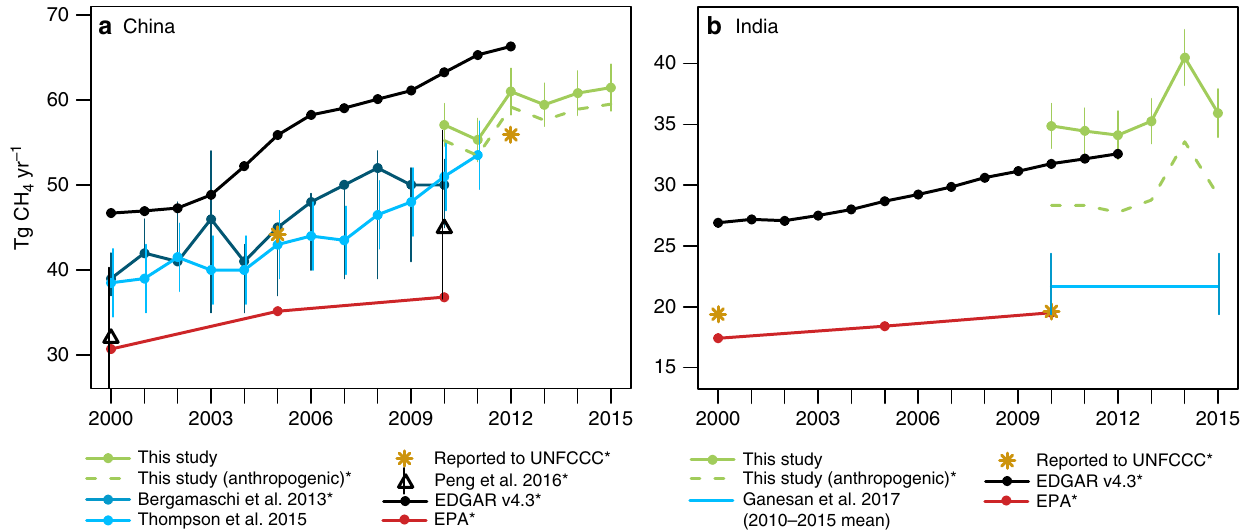
Fig. 2 Methane emissions estimates for China and India. a CH 4 emissions estimates for China from this study, Bergamaschi et al. 10 , Thompson et al. 12 , UNFCCC 35 , Peng et al. 6, the EDGAR v4.3 inventory 4 , and the US EPA 9 ; and b for India from this study, Ganesan et al. 28 , UNFCCC 53 , and US EPA 9 . We fi nd a trend in emissions from both countries for 2010 – 2015, though the trend for India is uncertain. Note that uncertainty estimates for this study are 95% con fi dence intervals, and uncertainty bounds for Bergamaschi et al. 10 re fl ect the range of different inversions that use different datasets (e.g., in situ, satellite). Estimates marked with an asterisk are for anthropogenic emissions only. Furthermore, the dashed green line represents the posterior emissions estimate after subtracting the wetland emissions model, biomass burning inventory (GFED), and termite emissions